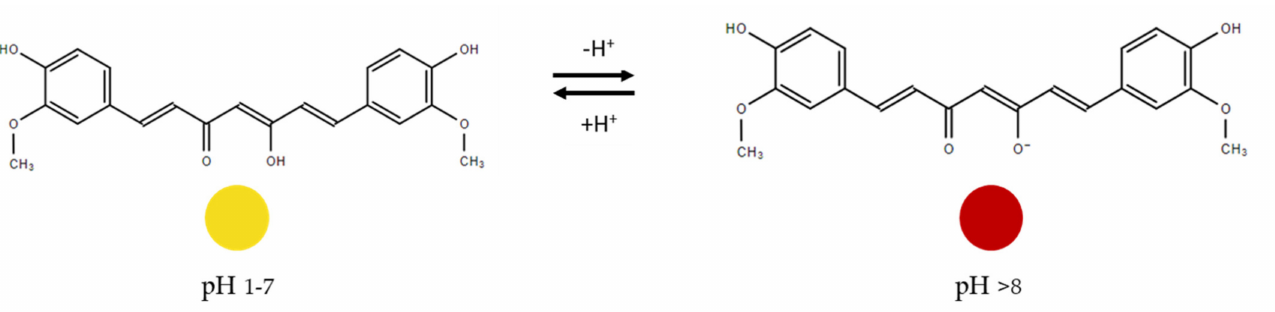
Figure 4. Changes in curcumin structure due to pH changes, adapted from [5]. Curcumin was used as a sensing material to develop a film with tara gum and polyvinyl alcohol [77]. Different concentrations (0, 0.1, 0.3, and 0.5% wt %) of curcumin were added to the filmogenic dispersion, and films were developed through the casting method. Curcumin addition caused a slight decrease in the barrier properties of the films. To evaluate the sensing ability of the films to act as intelligent packaging, films were placed on the inside of a petri dish containing fresh shrimp, and the changes in color were studied at ambient temperature. At the initial time, films showed a yellow color and at the end of the experience presented an orange–red color. This was due to pH changes of the shrimps, caused by their degradation and resulting in the increment of the total basic volatile nitrogen content through ammonia production. The antioxidant and antimicrobial properties were not evaluated in this study. The film showed potential to be used in intelligent